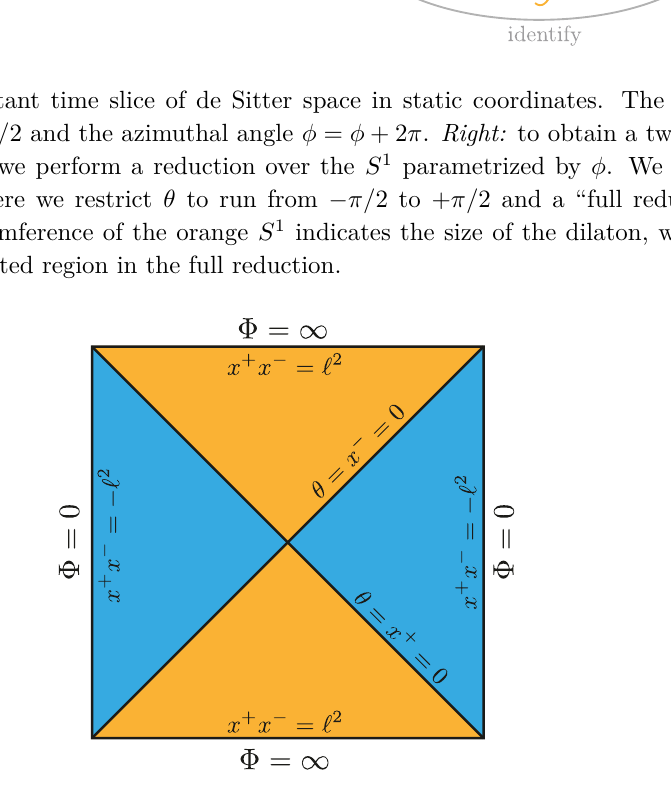
Figure 2 . Penrose diagram of two-dimensional de Sitter space obtained as a half reduction where we restrict Φ ≥ 0 and impose reflecting boundary conditions at Φ = 0 . The static coordinates (2.6) cover the two static patches shaded in blue and the coordinates x ± (see (2.15)) cover both the blue and orange shaded